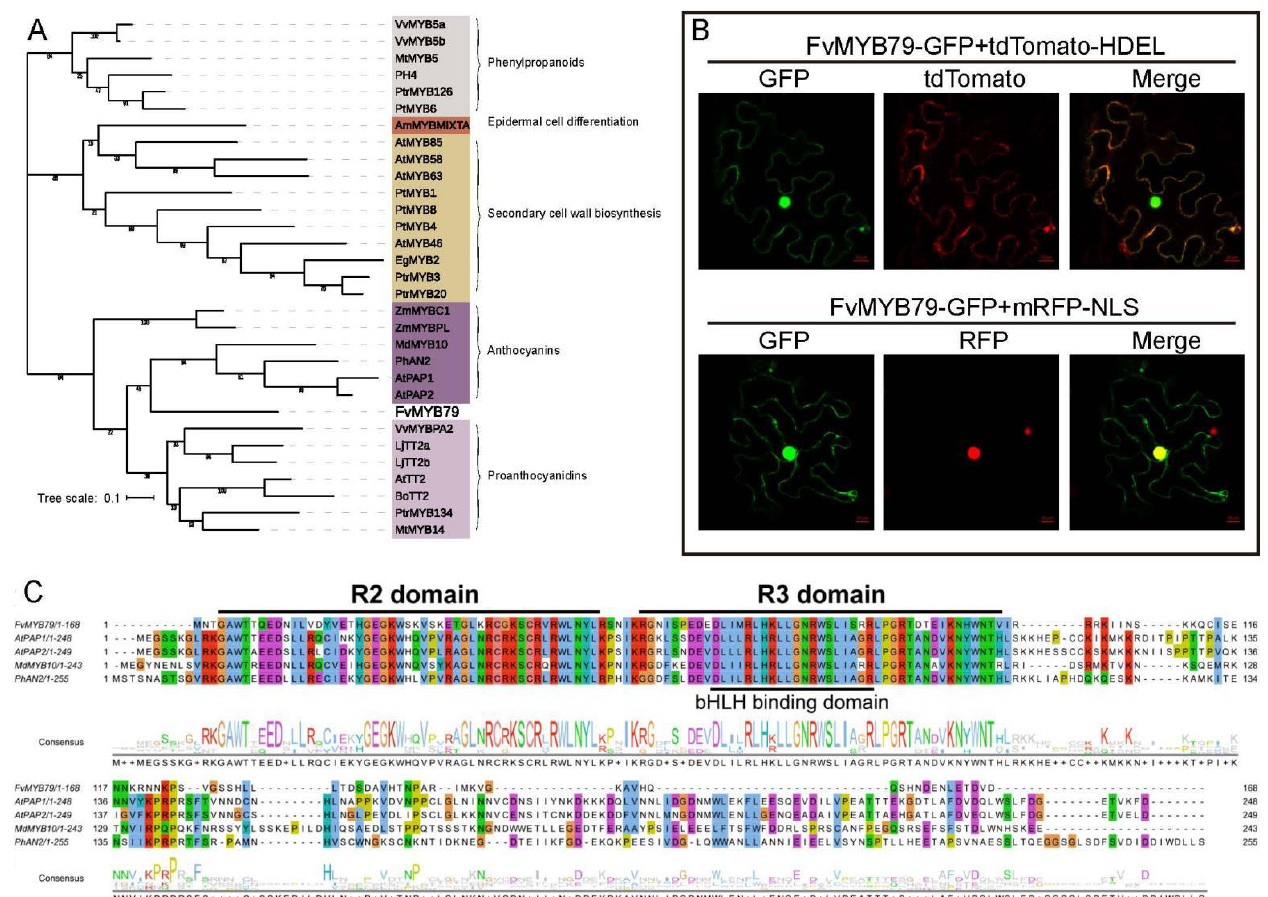
Figure 3. Phylogenetic analysis and subcellular localization of FvMYB79. ( A ) A phylogenetic tree was constructed by the maximum likelihood method of MEGA X software. Bootstrapping was performed 1000 times to obtain support values for each branch. ( B ) Subcellular localization of FvMYB79 was determined by FvMYB79-GFP fusion protein in tobacco leaf epidermal cells. ( C ) Alignment of the amino acid sequences of FvMYB79, AtPAP1, AtPAP2, MdMYB10 and PhAN2. R2 and R3 MYB-DNA-binding domains are underlined.